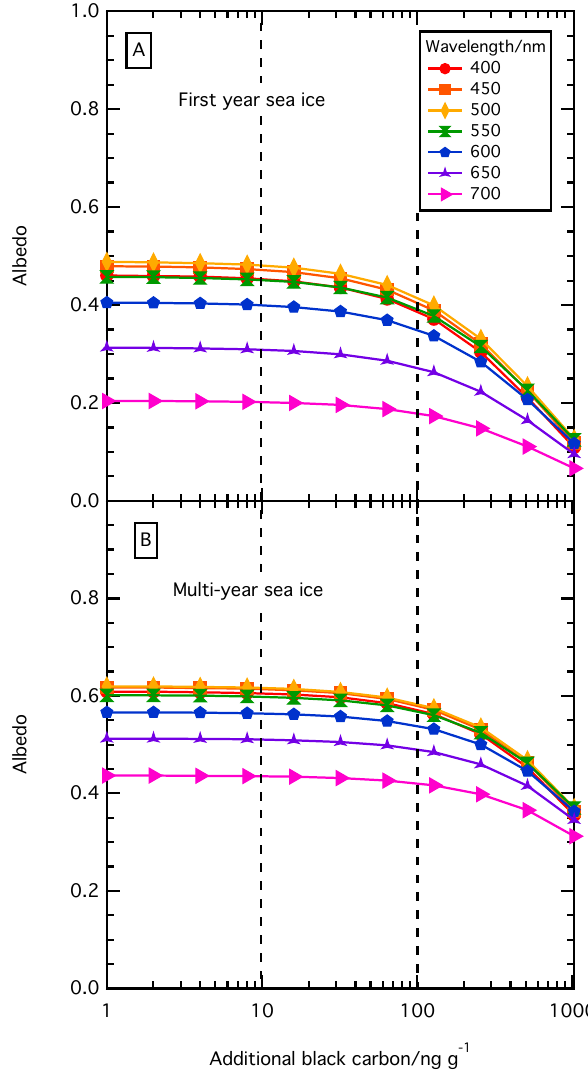
Fig. 3. (A) Albedo with increasing additional black carbon content from 1 to 1024ngg − 1 , evenly distributed in the top 5cm of 155cm of typical first-year sea ice. (B) Albedo with increasing black carbon content from 1 to 1024ngg − 1 , evenly distributed in the top 5cm layer of 155cm of a typical multi-year sea